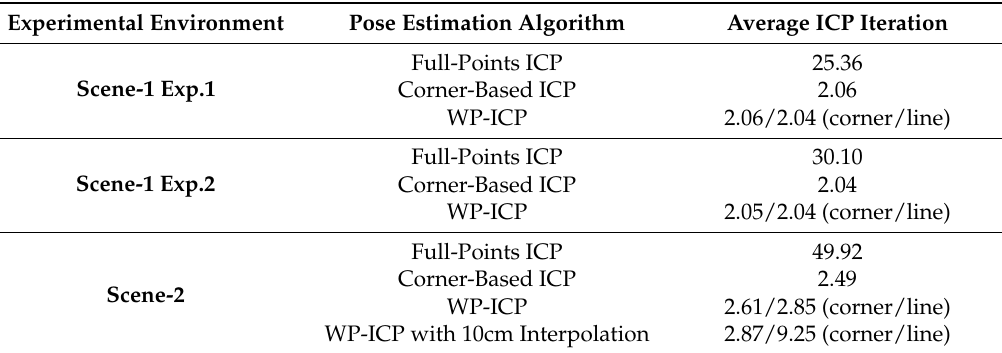
Table 1. ICP iteration